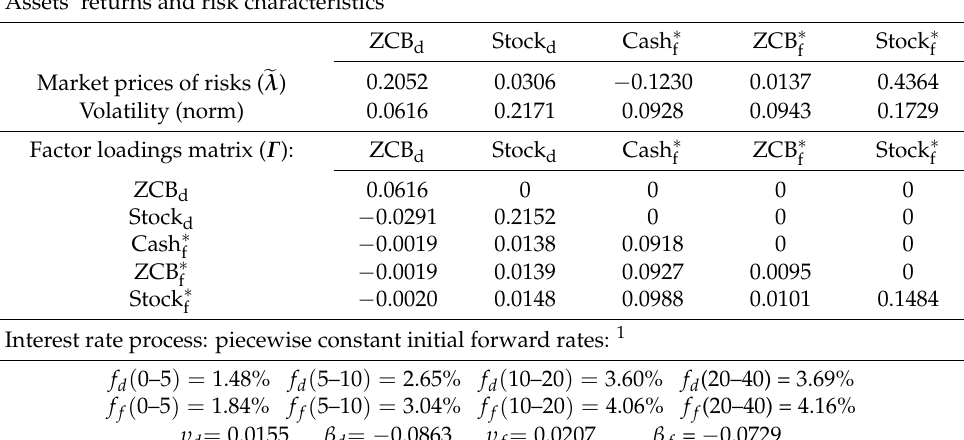
Table 1. Estimates of model